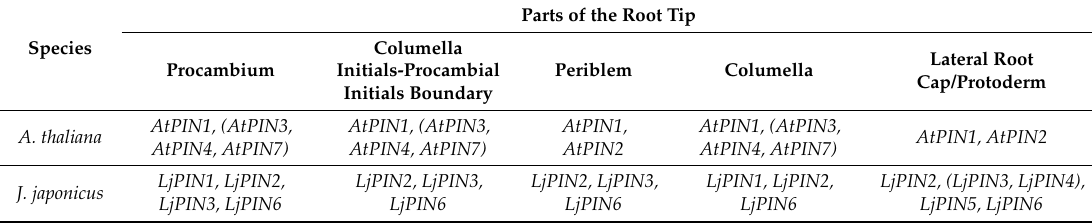
Table 3. Comparison of the location of PIN proteins in particular parts of the A. thaliana root tips (based on [40–42]) with the expression pattern of the L. japonicus PIN promoters observed in this work. Transporters or genes constituting a functional group in a particular species are included in brackets. Parts of the Root Tip Species